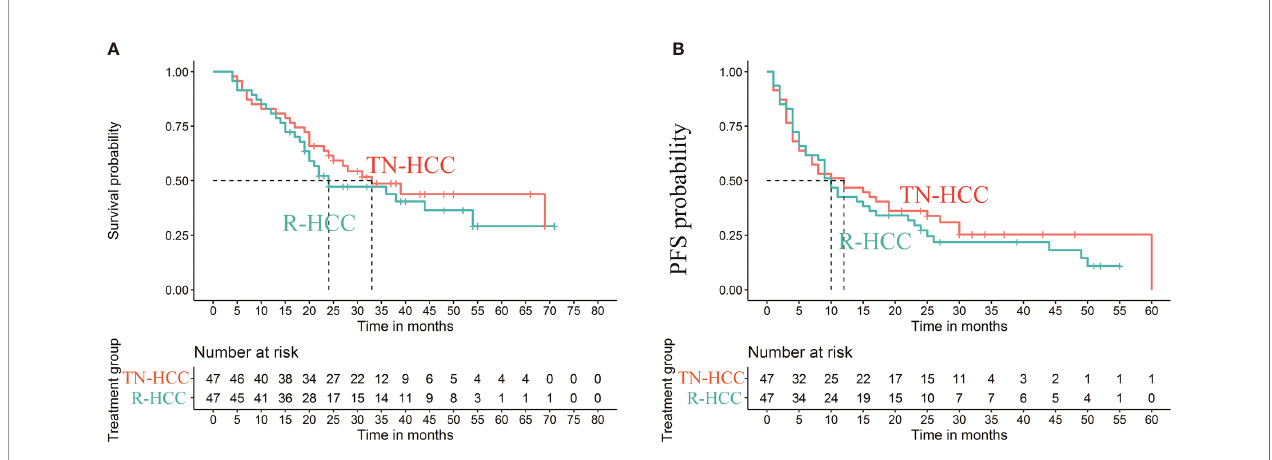
FIGURE 3 | Kaplan-Meier curves of cumulative survival (A) and progression-free survival (PFS) (B) in patients with recurrent HCC after liver resection and treatment- naïve HCC after propensity score matching.